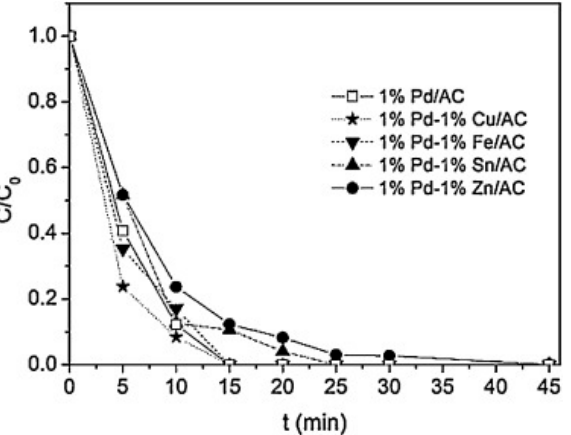
Figure 3. Evolution of the dimensionless concentration of bromate for reduction experiments using H 2 and bimetallic palladium catalysts supported on activated carbon (AC). Reprinted from [67], Copyright (2015), with permission from Elsevier.